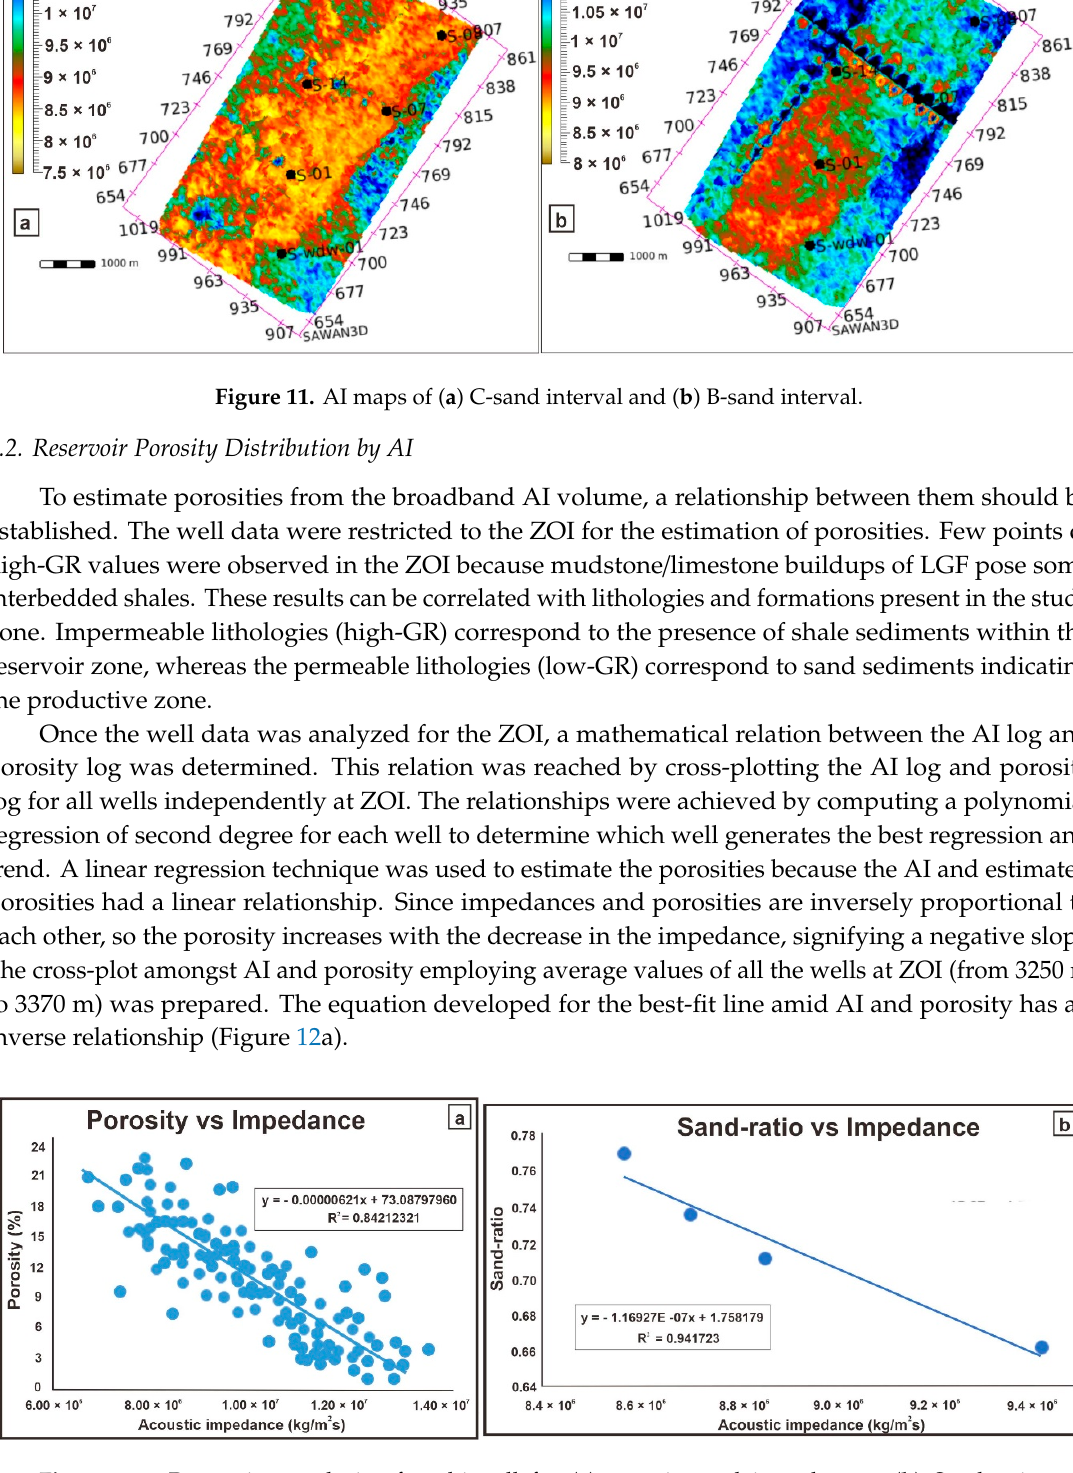
Figure 12. Regression analysis of multi-well for ( a ) porosity and impedance. ( b ) Sand-ratio versus impedance.